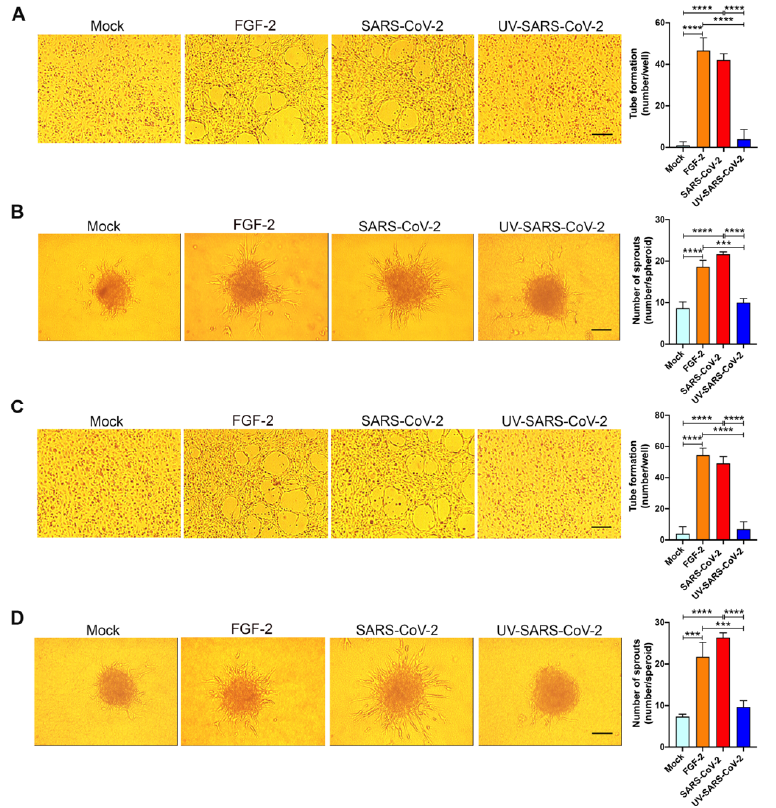
Figure 4. SARS-CoV-2 induces angiogenesis in HL-mECs by conditioning the microenvironment. HL-mECs were mock-infected (Mock) or infected with SARS-CoV-2 (SARS-CoV-2) or UV-inacti- vated SARS-CoV-2 (UV-SARS-CoV-2) at MOI 1, for 1 h at 37 °C and then washed and cultured until day 3 p.i. ( A ) Mock-, SARS-CoV-2-, and UV-SARS-CoV-2 HL-mECs were seeded on